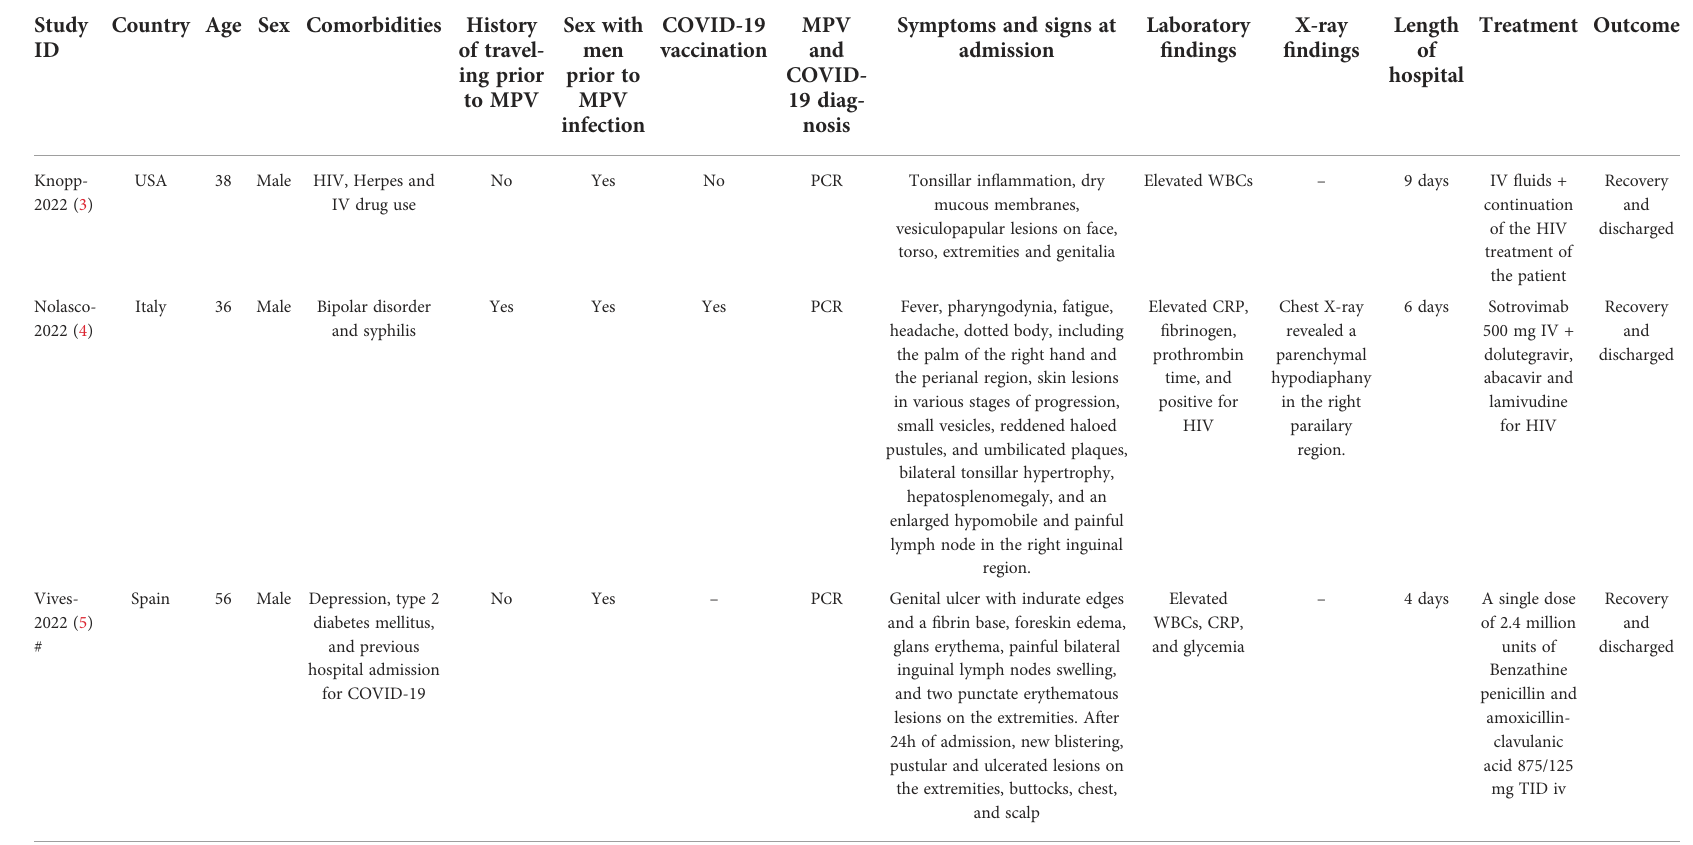
TABLE 1 Characteristics of patients with COVID-19 and MPV